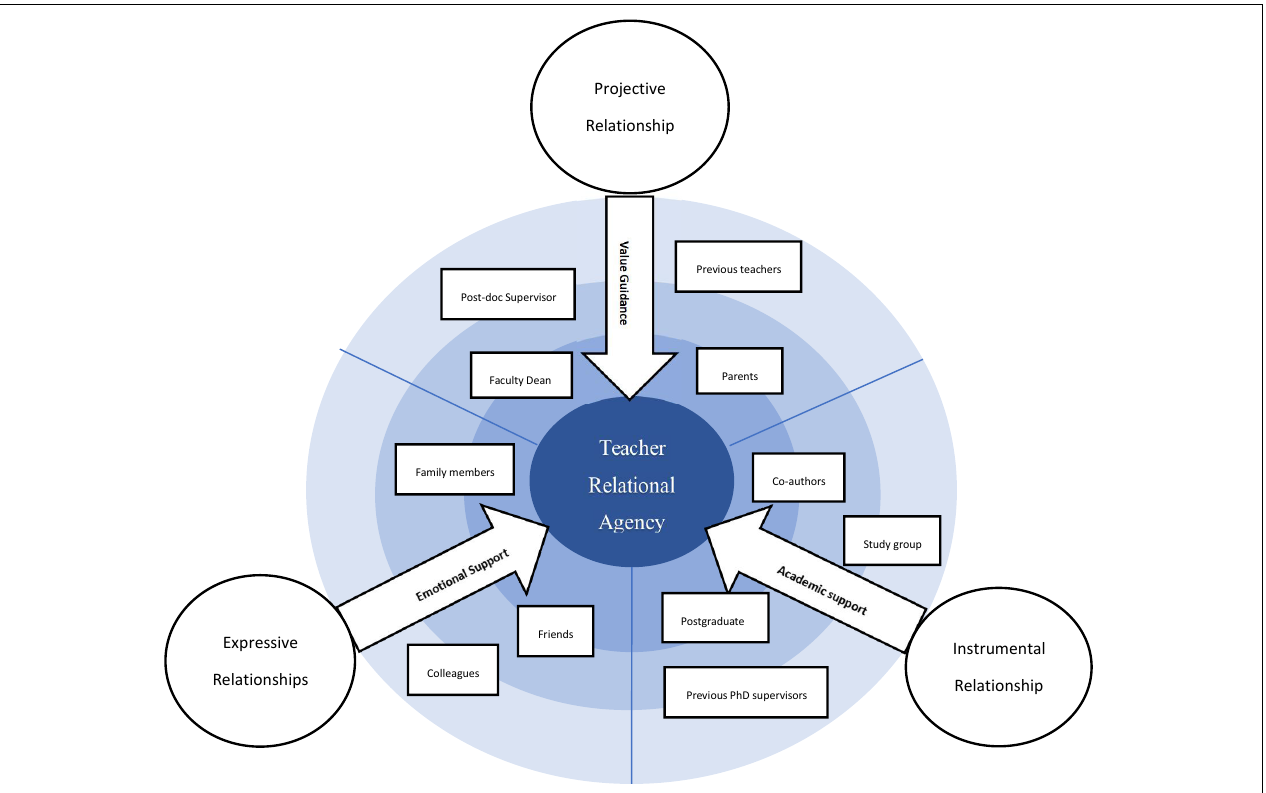
FIGURE 5 | A concentric circle model of relational